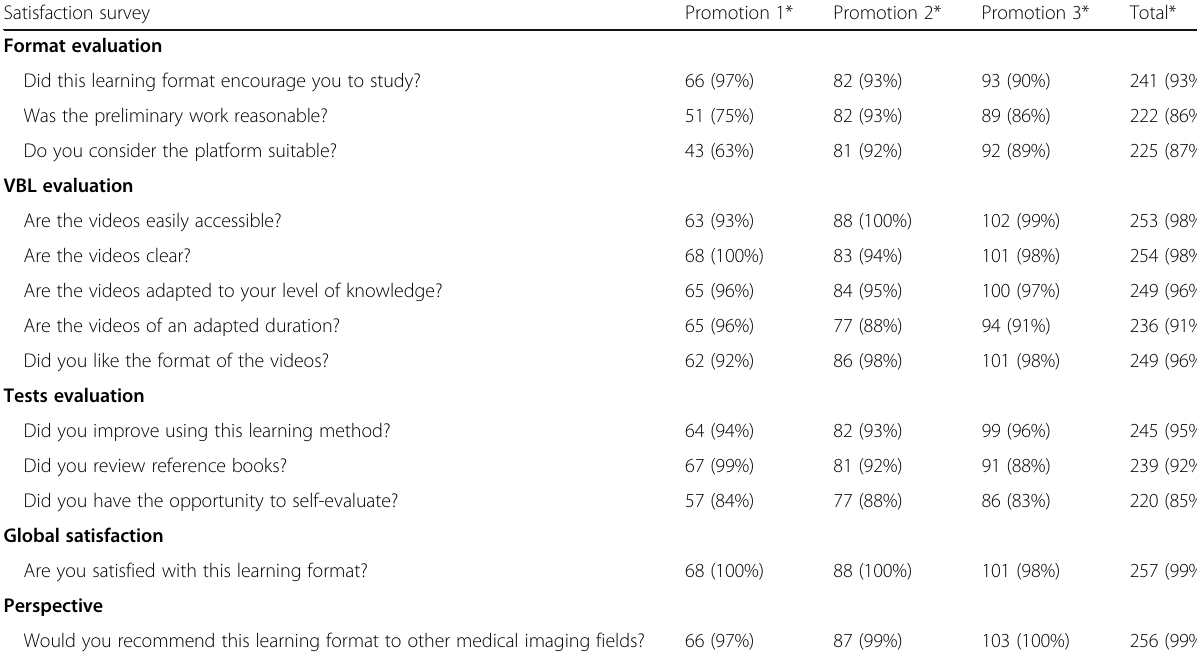
Table 4 Directed feedback collected from students during the face-to-face optional course Satisfaction